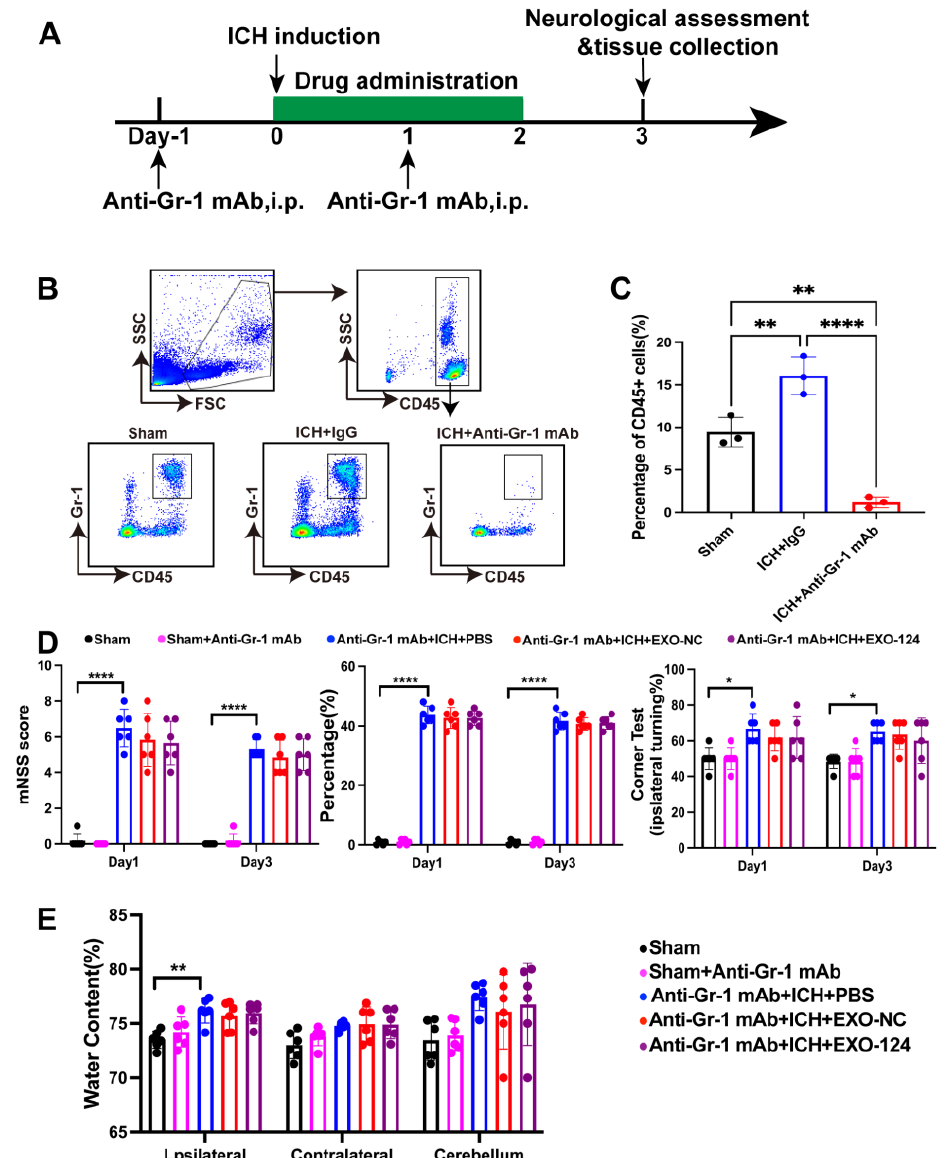
Figure 7. Gr-1 + myeloid cells are involved in the protective effect of miRNA-124-enriched microglia- derived exosomes. ( A ) Flow chart showing the drug administration protocol and experimental design. ( B , C ) Representative flow cytometry plots showing the gating strategy for circulating Gr- 1 + cells in mice. n = 3/group, mean ± SD, ** p < 0.01, **** p < 0.0001. ( D ) Summary of mNSS score and performance in the foot-fault test and corner turning test on days 1 and 3 after ICH induction following administration of Gr-1 mAb or the indicated. n= 6/group, mean ± SD, * p < 0.05, **** p < 0.0001. ( E ) The bar graph shows the brain water content in ICH mice that received Gr-1 mAb or the indicated treatment. n = 6/group, mean ± SD,** p <